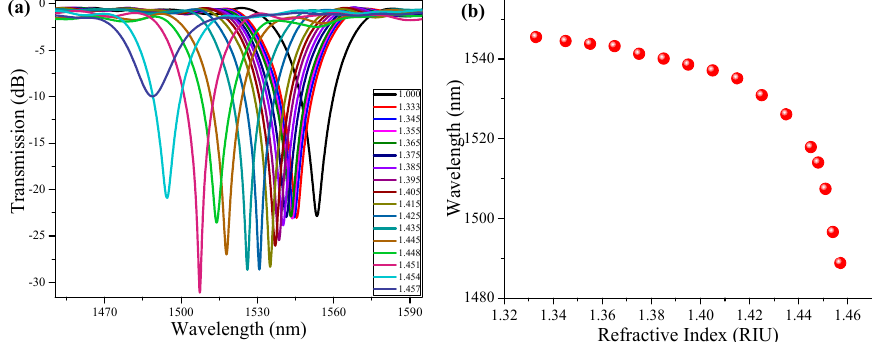
Figure 4. Refractive index sensing characteristics of LPFG: ( a ) Transmission spectra of the LPFG with different surrounding refractive index; ( b ) dependence of the resonance wavelength on the surrounding refractive index.